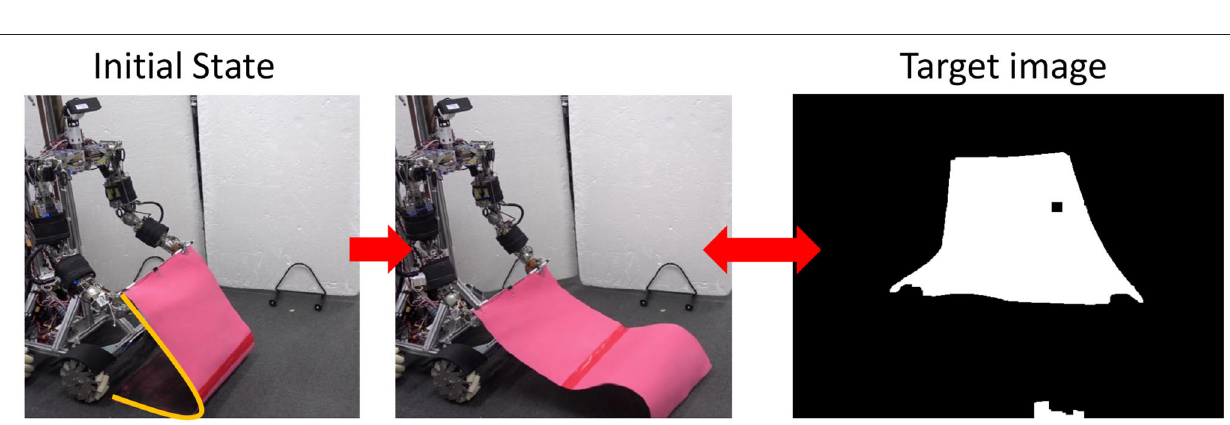
motion, where the upraised shoulder and elbow are lowered down significantly (the larger the joint angle is, the lower the arm is). Here, if we look at f const , we can see that in many cases, the stiffness is increased in the first half and decreased in the second half. This increases the hand speed and causes the cloth to